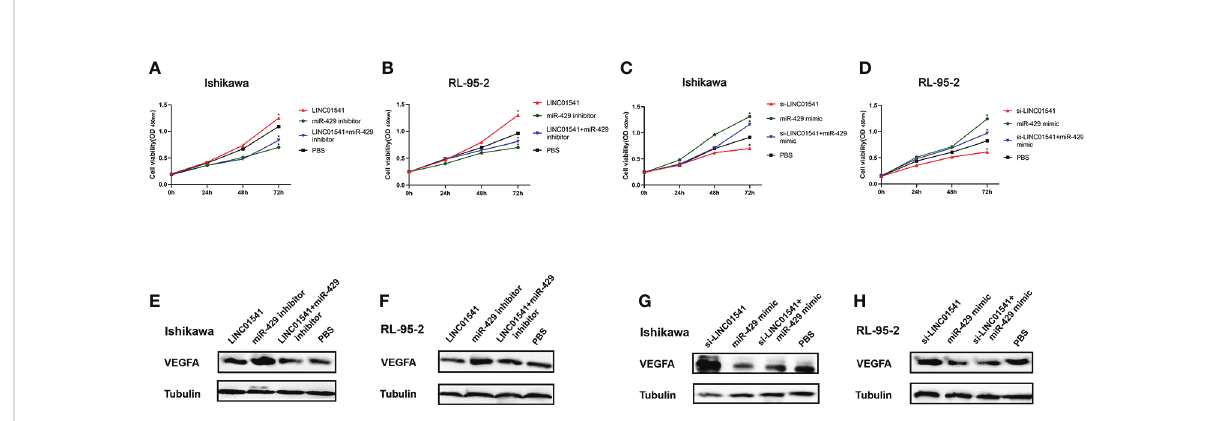
FIGURE 6 Construction of a co-cultivation system after cell transfections. (A, B) CCK-8 used for rescue experiments in Ishikawa and RL95-2 cells demonstrated that LINC01541 promoted cell proliferation, but a mixture of LINC01541 overexpression and miR-429 inhibitor reversed this effect. (C, D) In both cell lines, the knockdown of LINC01541 inhibited cell proliferation, but a mixture of LINC01541 knockdown and miR-429 mimic reversed this effect. (E – H) Western blot analysis demonstrated that LINC01541 and miR-429 inhibited the production of VEGFA. Western blot analysis used for rescue experiments demonstrated that a mixture of LINC01541 overexpression and miR-429 inhibitor had an intermediate effect on both cell lines. Similarly, a mixture of a knockdown of LINC01541 and miR-429 mimic had an intermediate effect on both cell lines. (* P